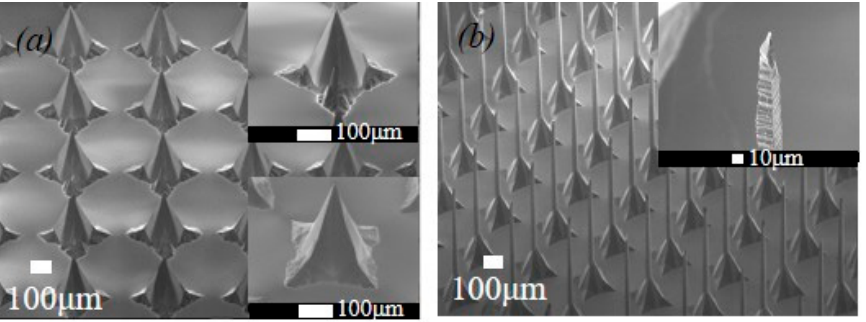
Figure 6. SEMs of Microneedle arrays with ( a ) 270 μ m height and 420 μ m pitch; ( b ) 900 μ m height and 340 μ m pitch.